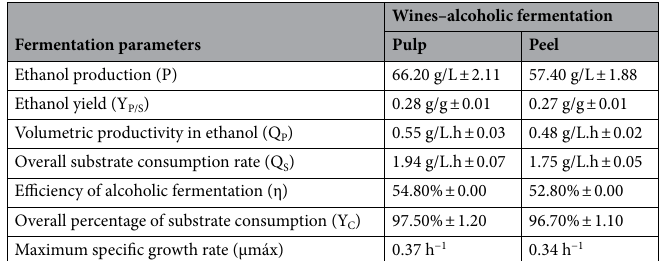
Table 2. Fermentation parameters of pineapple pulp and peel must